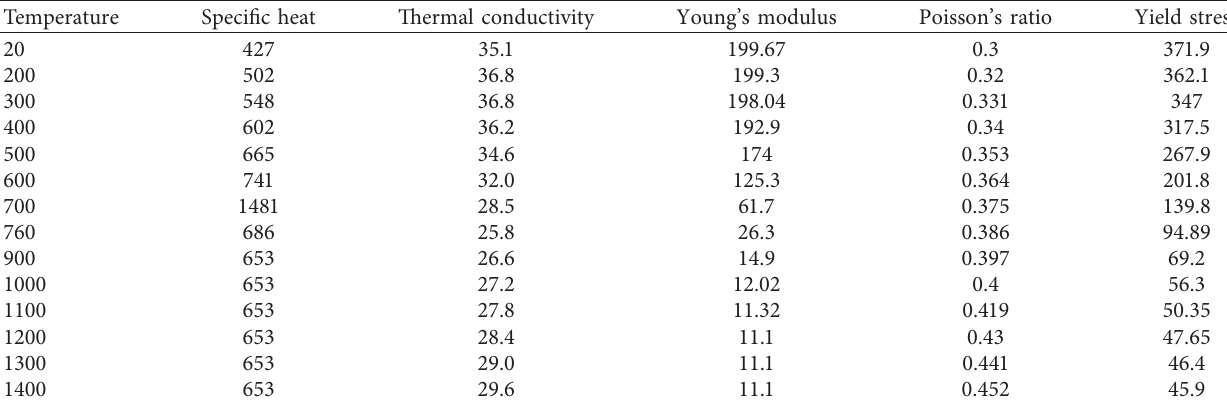
Table 3: Primary variables of shipbuilding steel (material